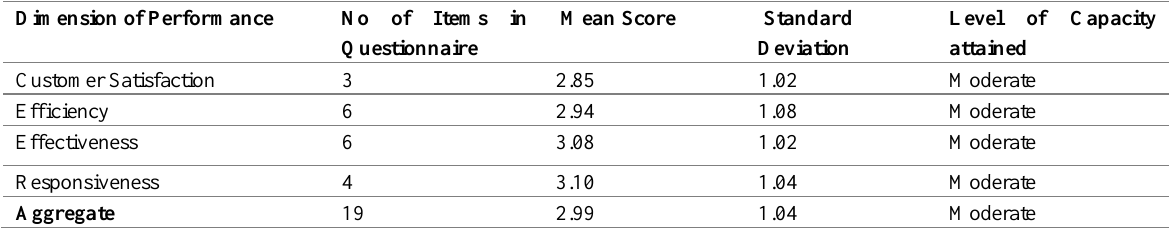
Table 4: Organizational Performance achieved from the level of OD attained